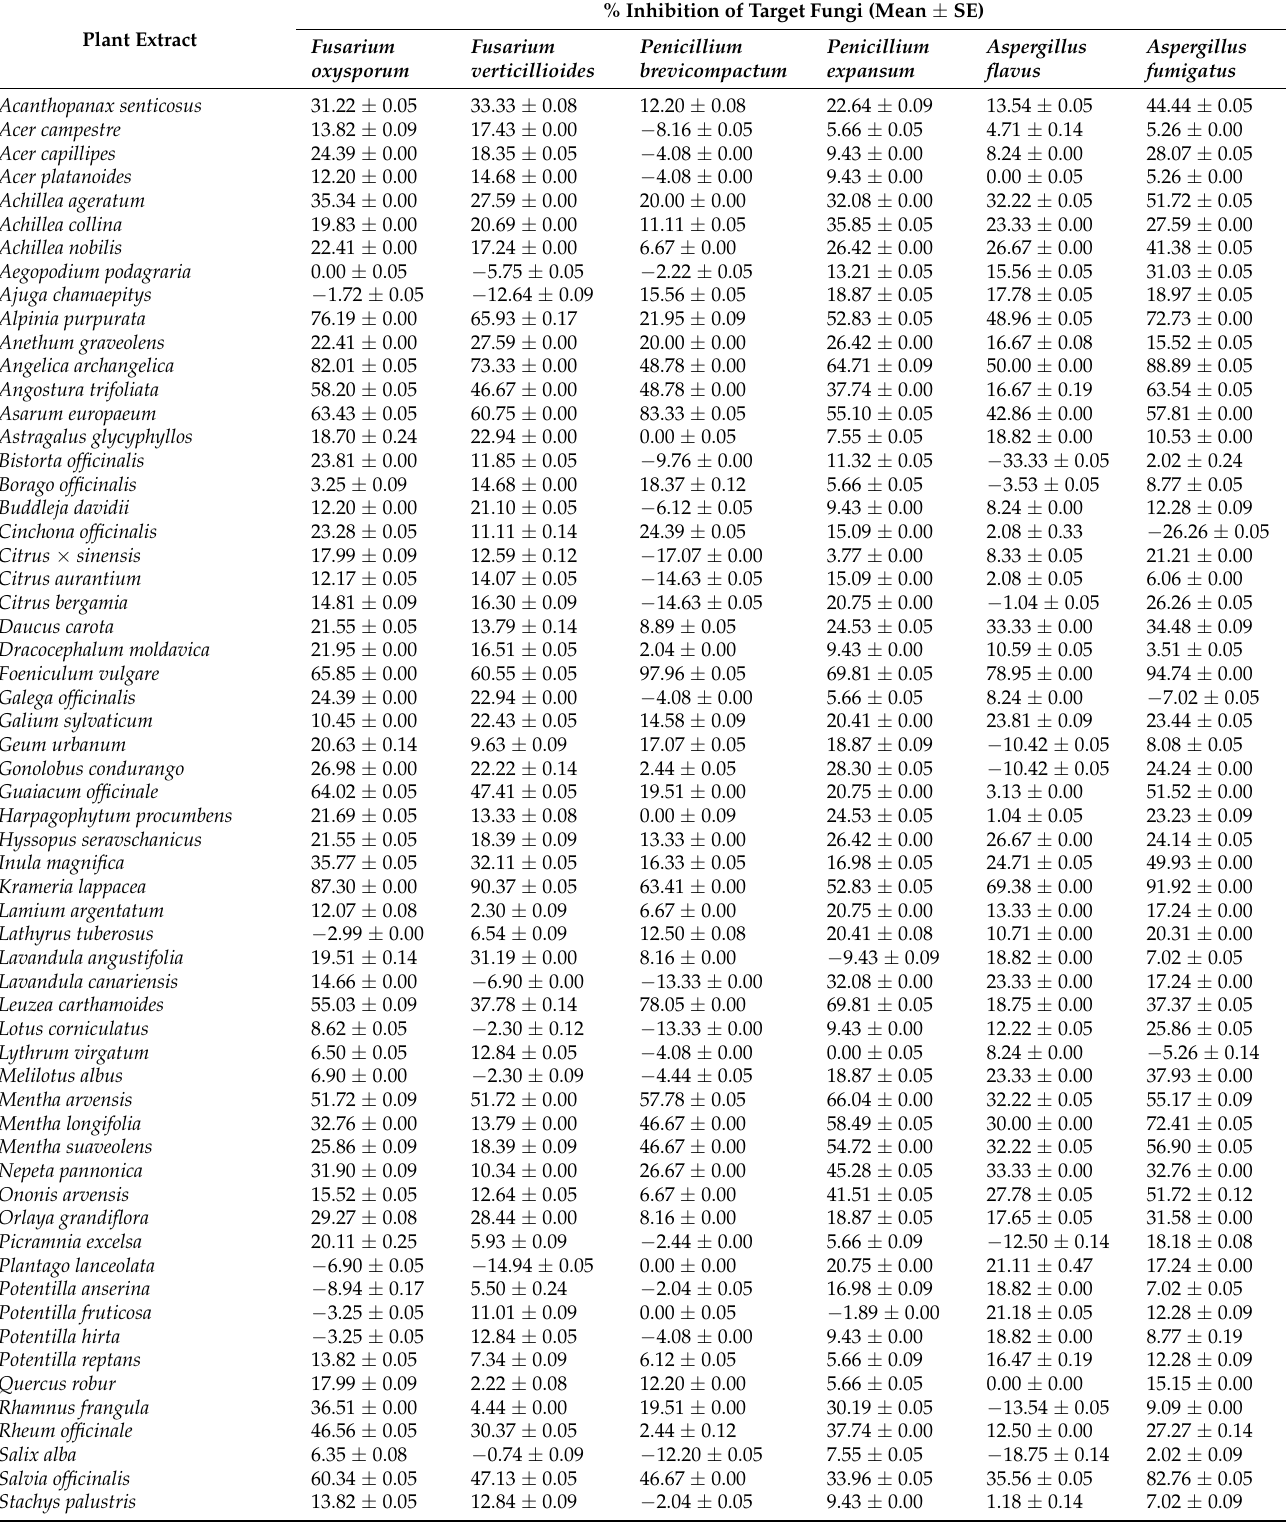
Table 2. Inhibition effect of plant extracts on pathogenic and toxinogenic fungi at concentration 2 mg mL − 1